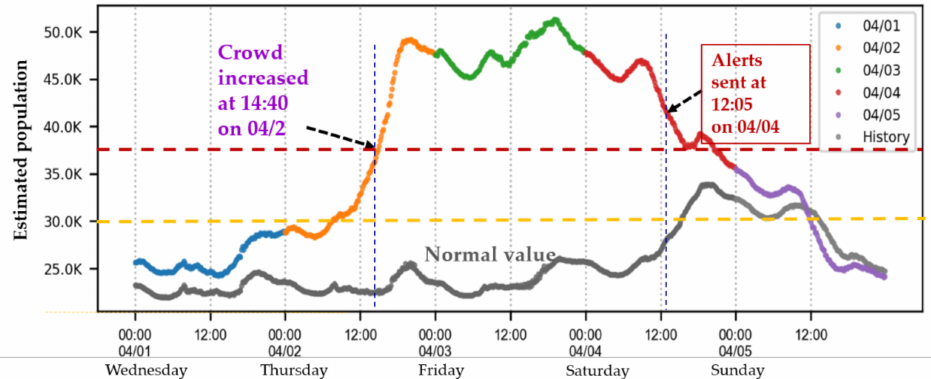
Figure 7. Crowd distribution in Hengchun Township from 1 to 5 April 2020, based on mobile